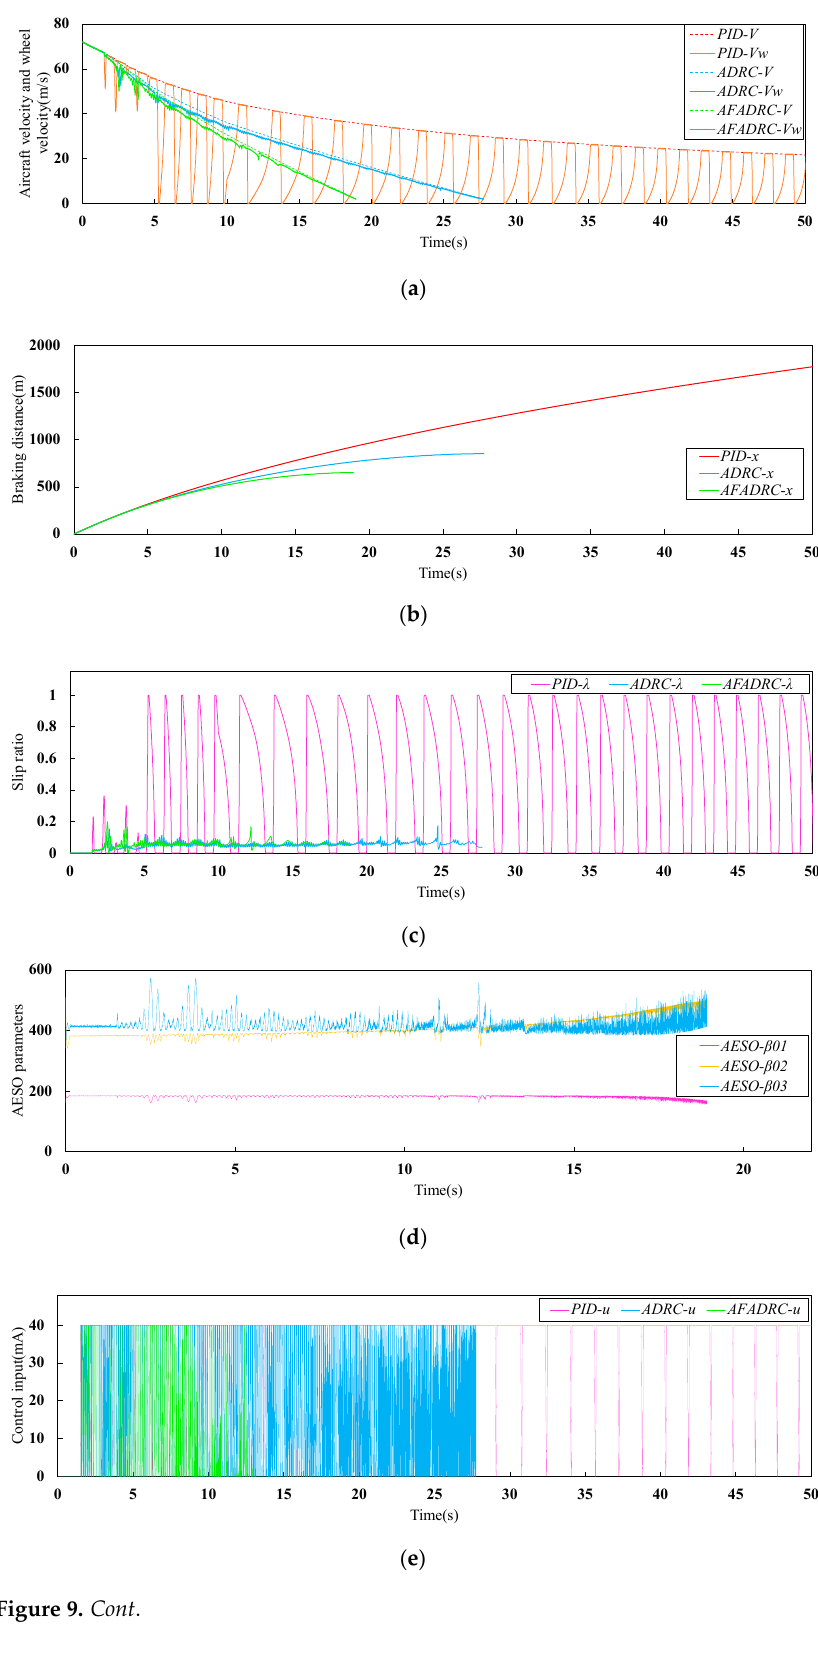
( f ) Figure 9. Case 3 simulation results: ( a ) aircraft velocity and wheel velocity; ( b ) breaking distance; ( c ) slip ratio; ( d ) AESO parameters; ( e ) control input; ( f ) extended state. Table 11. AABS performance index in Case 3. Performance Index